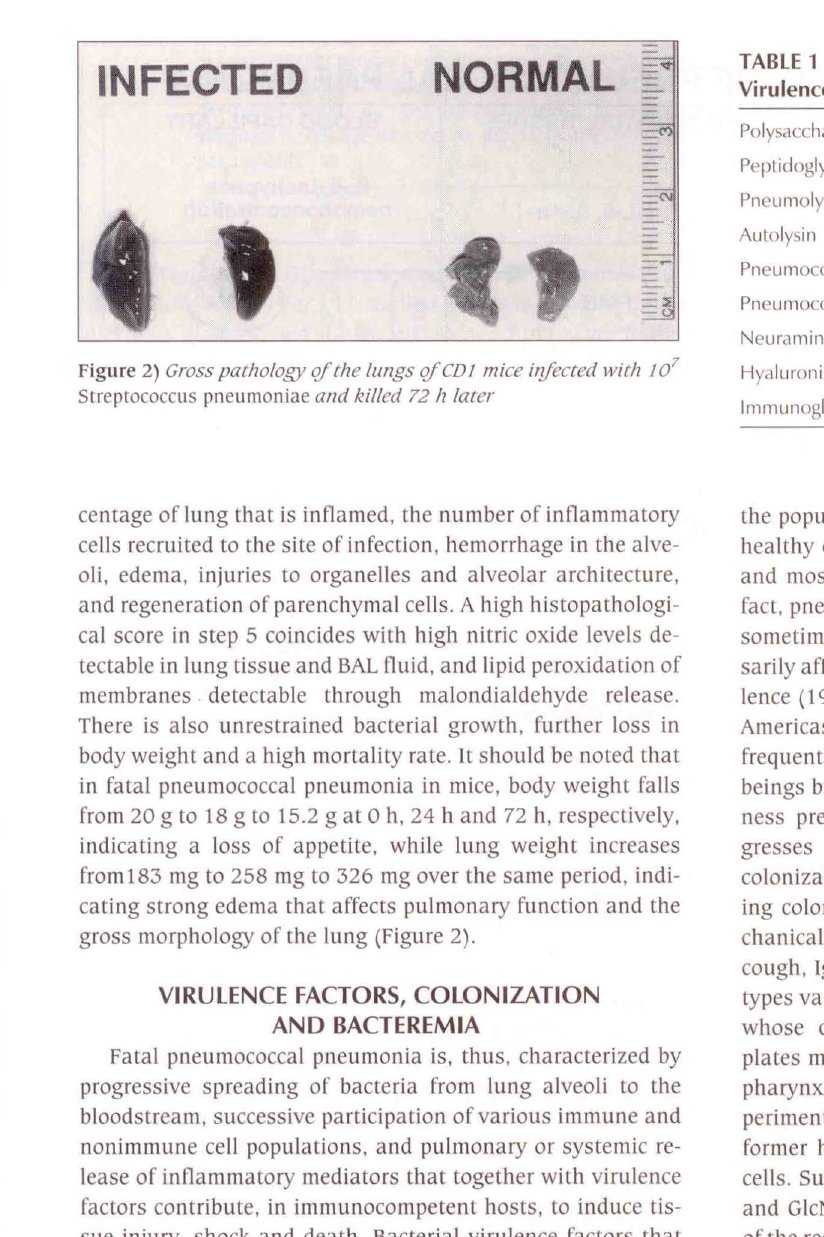
Virulence factors associated with Streptococcus pneumoniae Polysaccharicle capsule Pepticloglycan/t i hoic acid